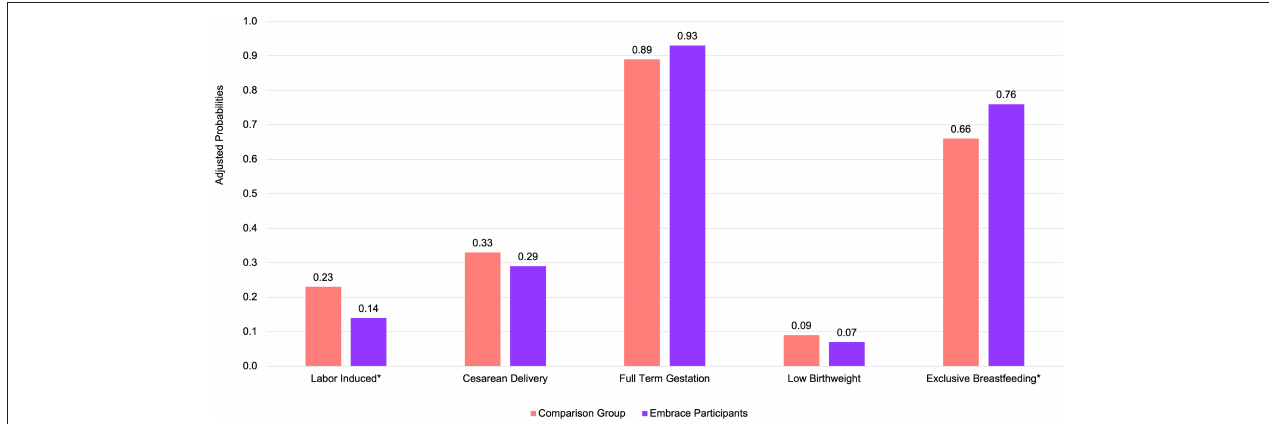
FIGURE 1 | Marginal effects of Embrace participation on the probability of pregnancy-related outcomes at Emory Decatur Hospital from 2016 to 2018 after adjusting for covariates. * p < 0.05; probabilities are adjusted for race, language spoken at home, parity, maternal age, insurance status, underlying conditions (pre-eclampsia and diabetes), and zip